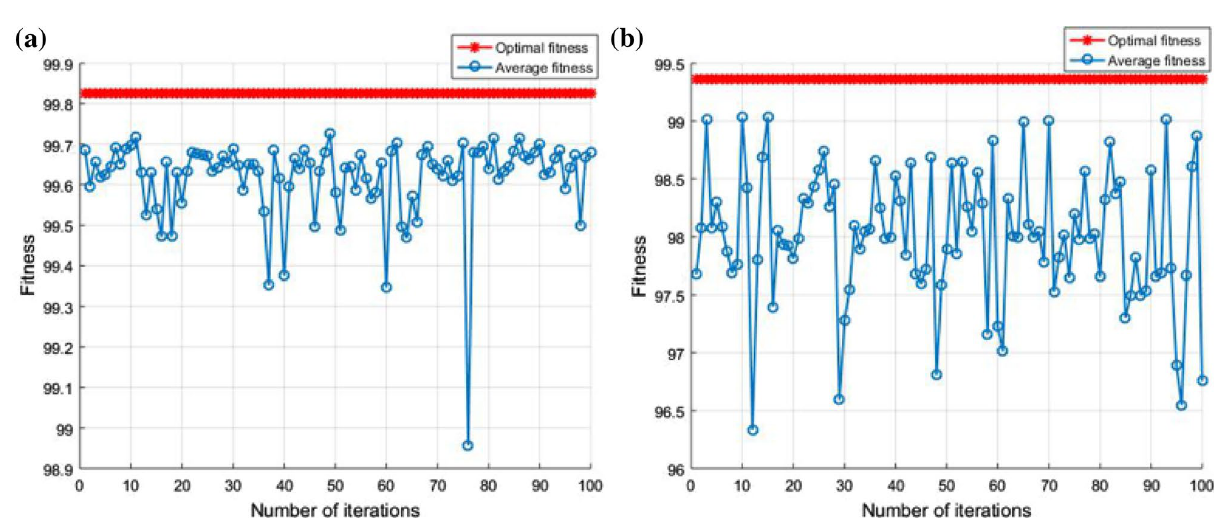
Figure 13. PSO-SVM fitness curve: ( a ) fitness curve for Case 1; ( b ) fitness curve for Case